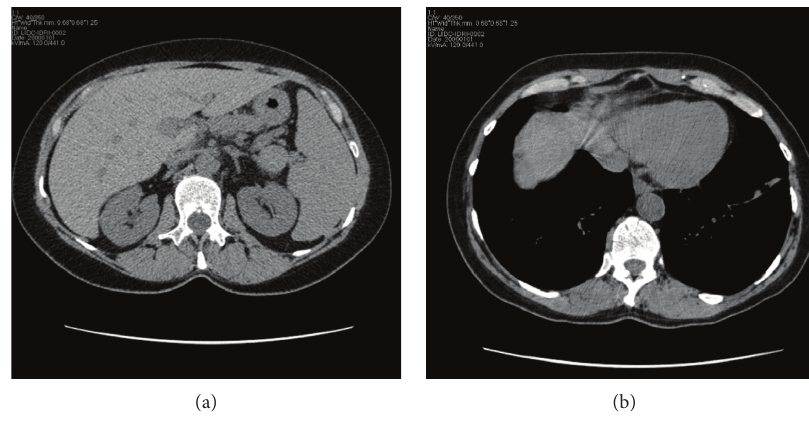
Figure 1: Picture of LIDC-IDRI data set.